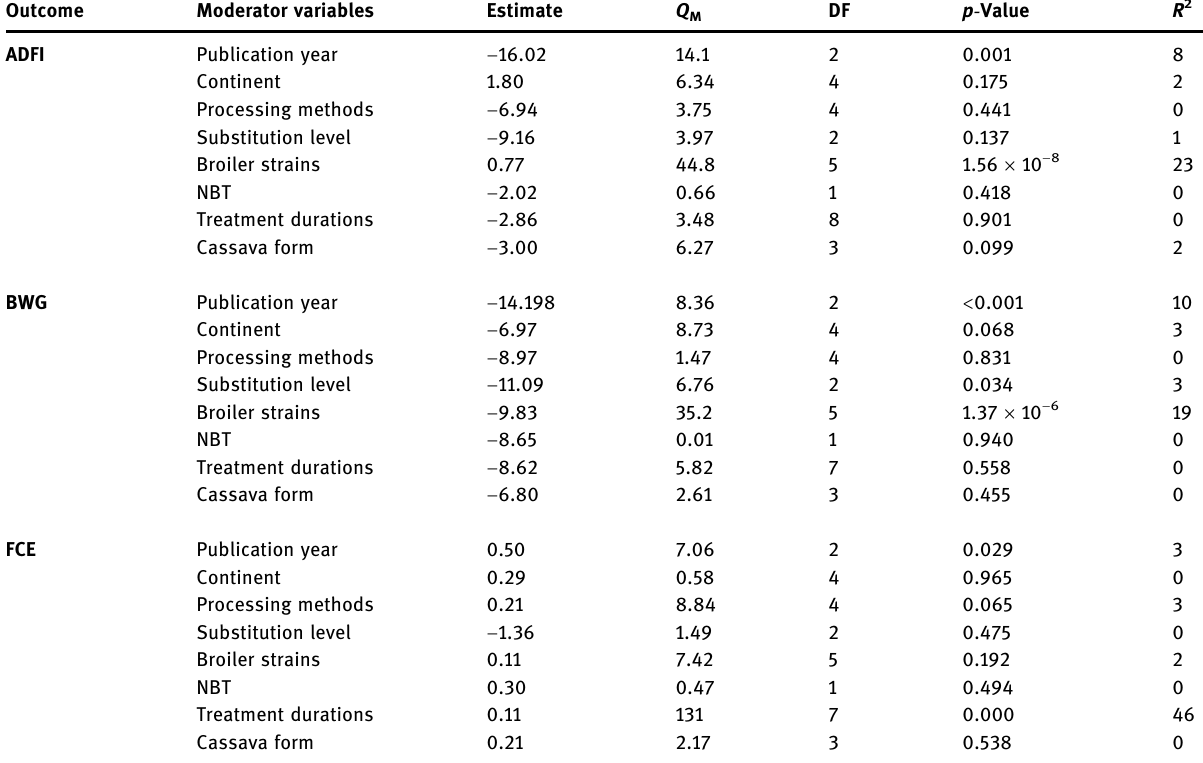
Table 6: Relationship between measured outcomes and moderator variables in broiler chickens fed cassava